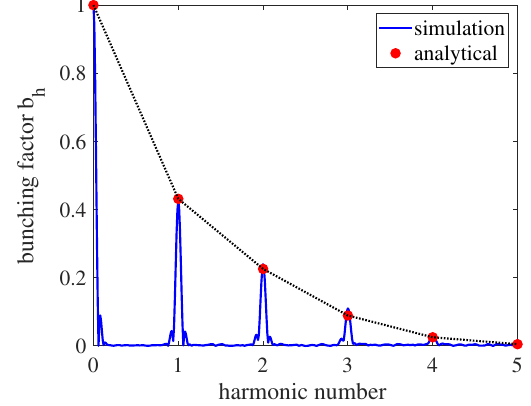
FIG. 2. Comparison of the bunching factors obtained via simulation and analytical formula.